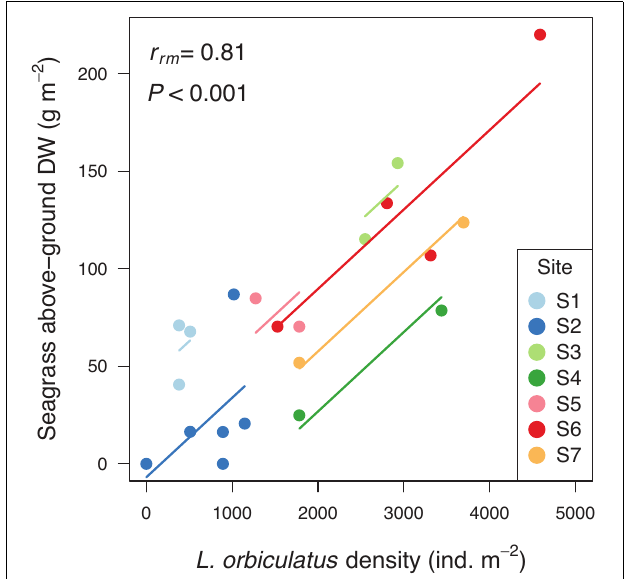
FIGURE 2 | Positive correlation between seagrass above-ground biomass and Loripes orbiculatus density. Benthic samples collected within the same sampling site are given the same color, with corresponding lines to show the repeated measures correlation fit for each sampling site. For the location of the different sampling sites within Thau lagoon see Figure 1B . DW = dry